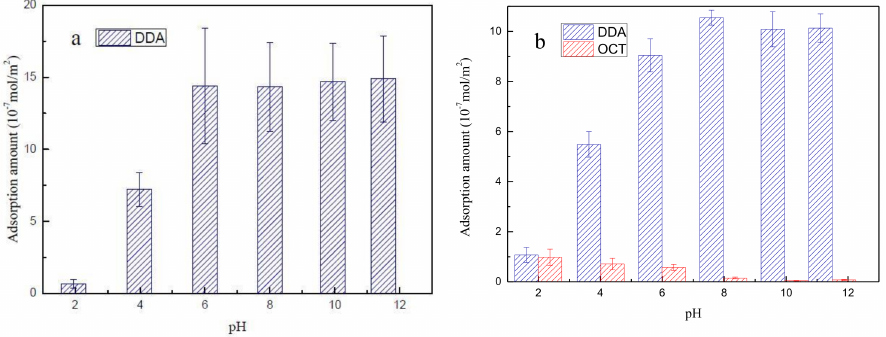
Figure 5. DDA adsorption on muscovite as a function of pH under treatment with ( a ) DDA alone and ( b ) mixed collector